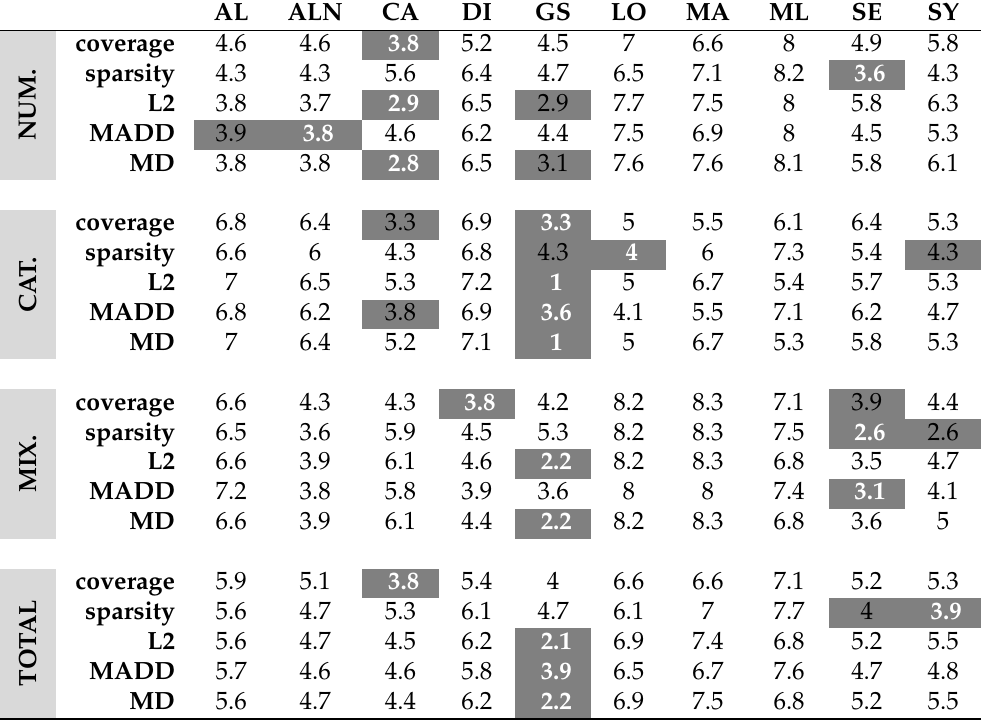
Table 4. Average rankings for dataset groupings. White bold ranking numbers highlight the best numerical result for each score and the gray cells show the algorithms that, statistically, can be considered the best. The results are rounded to one decimal place; then, in some cases, the best ranking can have the same numerical results as other, worse, scores. AL : ALIBIC, ALN : ALIBICNOGRAD, CA : CADEX, DI : DiCE, GS : Growing Spheres, LO : LORE, MA : MACE, ML : ML-Explain, SE : SEDC, SY : SynAS.